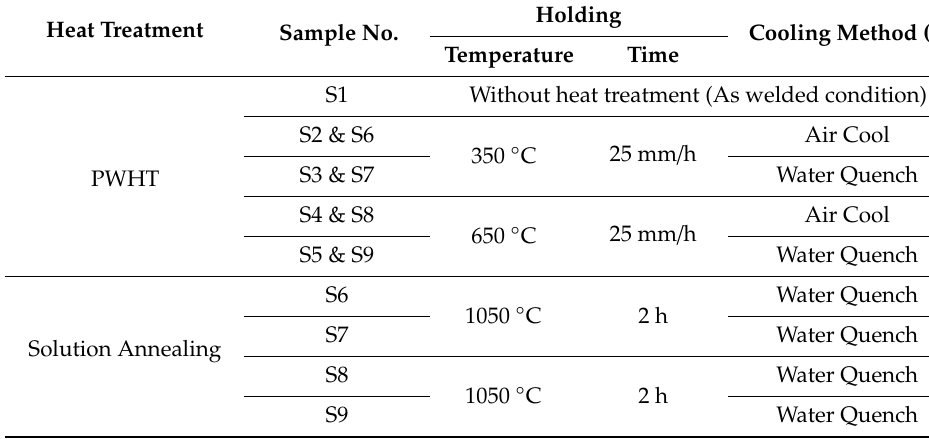
Table 3. Heat treatment